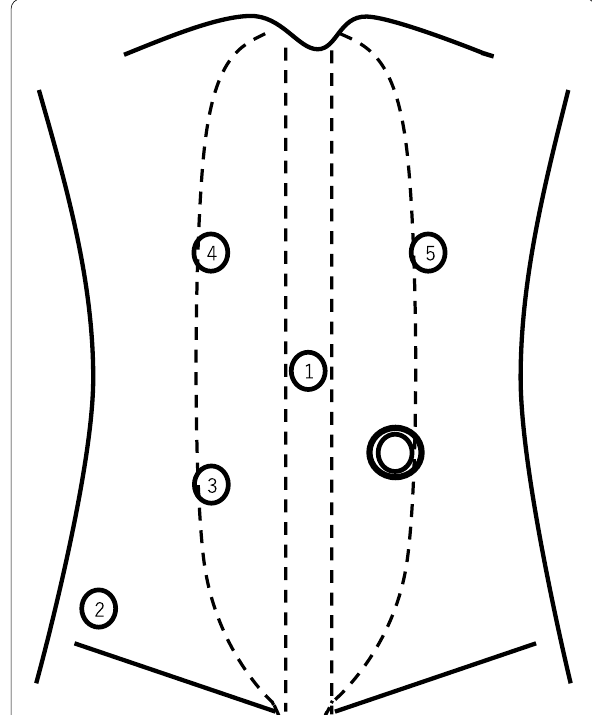
Fig. 6 In robotic surgery, the third and fourth trocars penetrate the right rectus abdominis muscle. A dotted line, numbers and double circles indicate the rectus abdominis muscle, order of port insertion and the sigmoid colostomy,